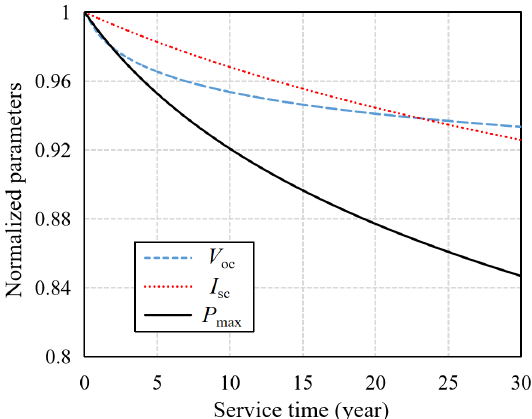
Figure 9. Electrical performance prediction of the GaInP/GaAs/Ge triple-junction PV cells served in the geosynchronous orbit.